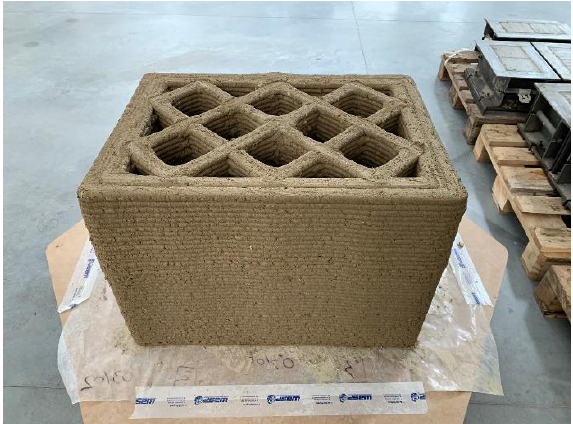
Figure 5. 3D-printed specimen in the fresh state.